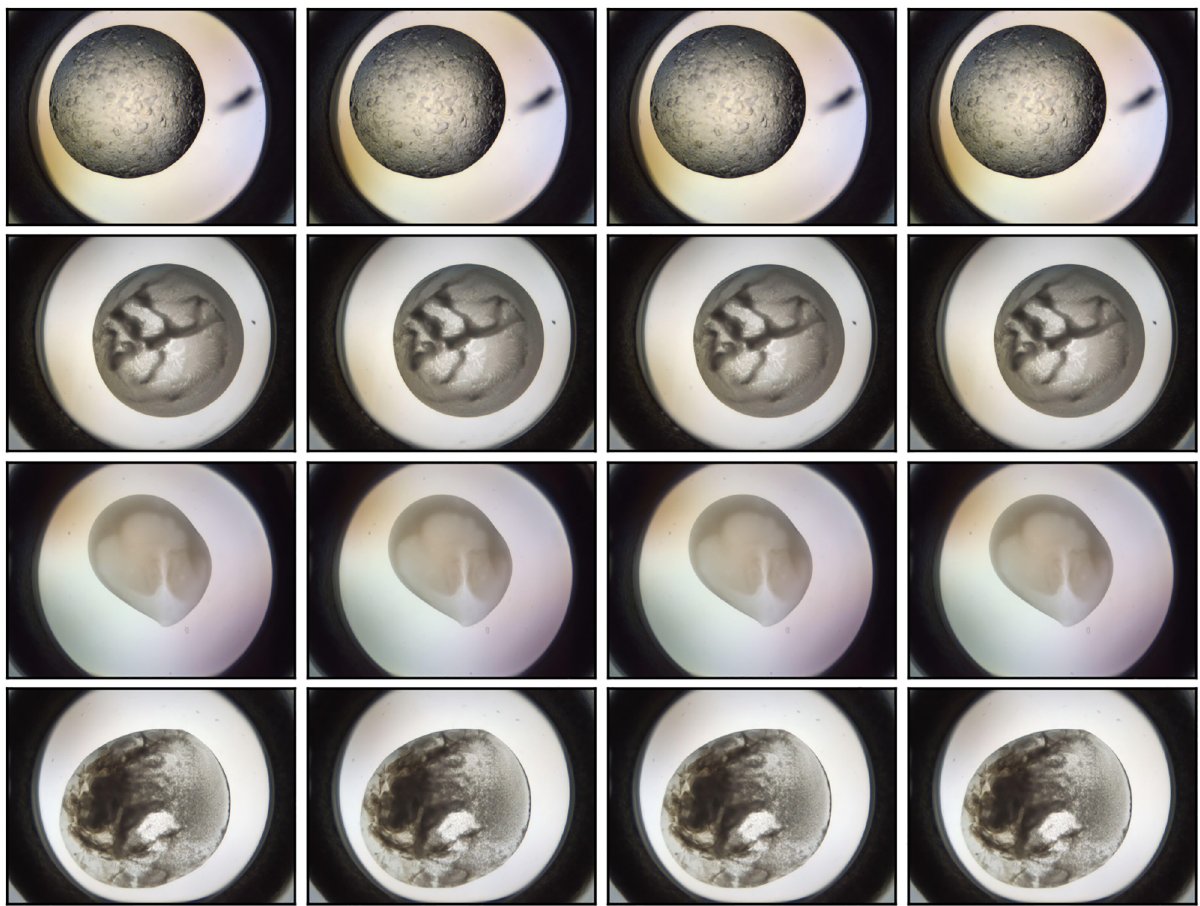
Fig 10. Examples of redundant images contained within the MARCO dataset. Each of these 16 images is found in the MARCO dataset, and are clustered into rows based on similarity as determined by the semantic redundancy process described in this Section. The similar images shown here are different timepoints of the same crystallisation experiment. Each image is so similar they cannot be distinguished apart by a human. There are other semantically redundant images that don’t appear the same, but contribute the same information to the model (not shown).